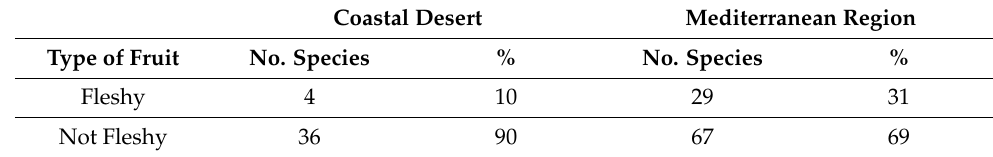
Table 1. Summary of the seed and fruit richness in the coastal desert and Mediterranean region. Coastal Desert Mediterranean Region Type of